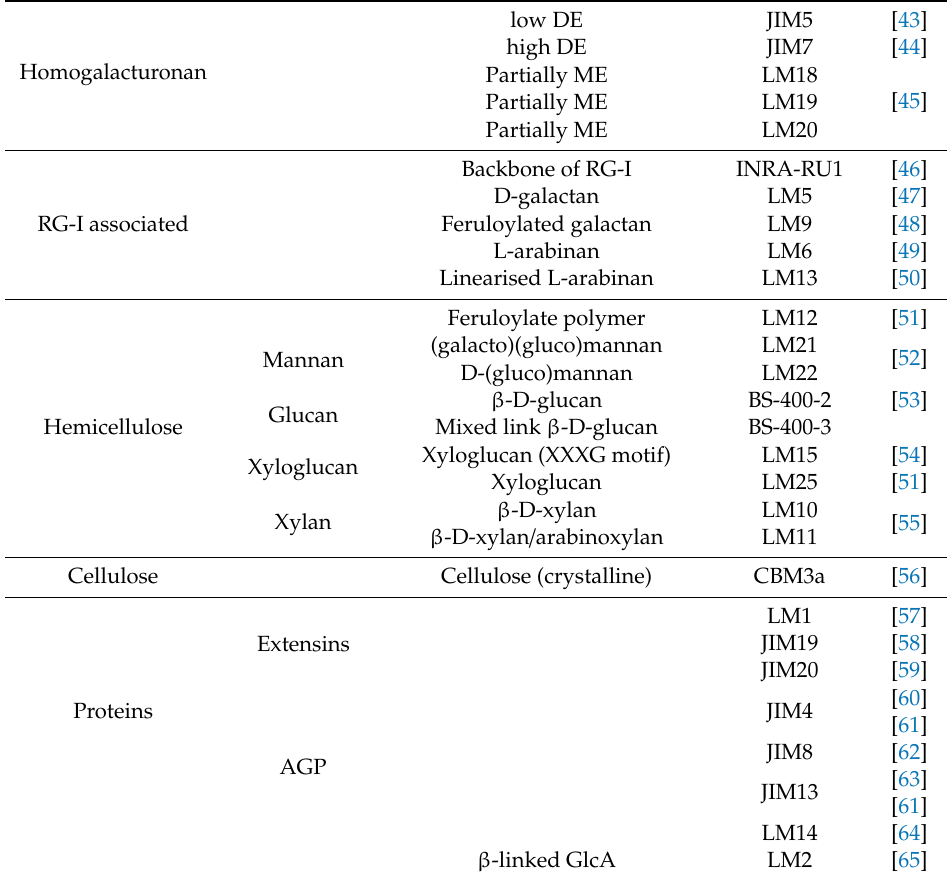
Table 2. List of monoclonal antibodies (mAbs) and CBMs used for the comprehensive microarray polymer profiling (CoMPP)